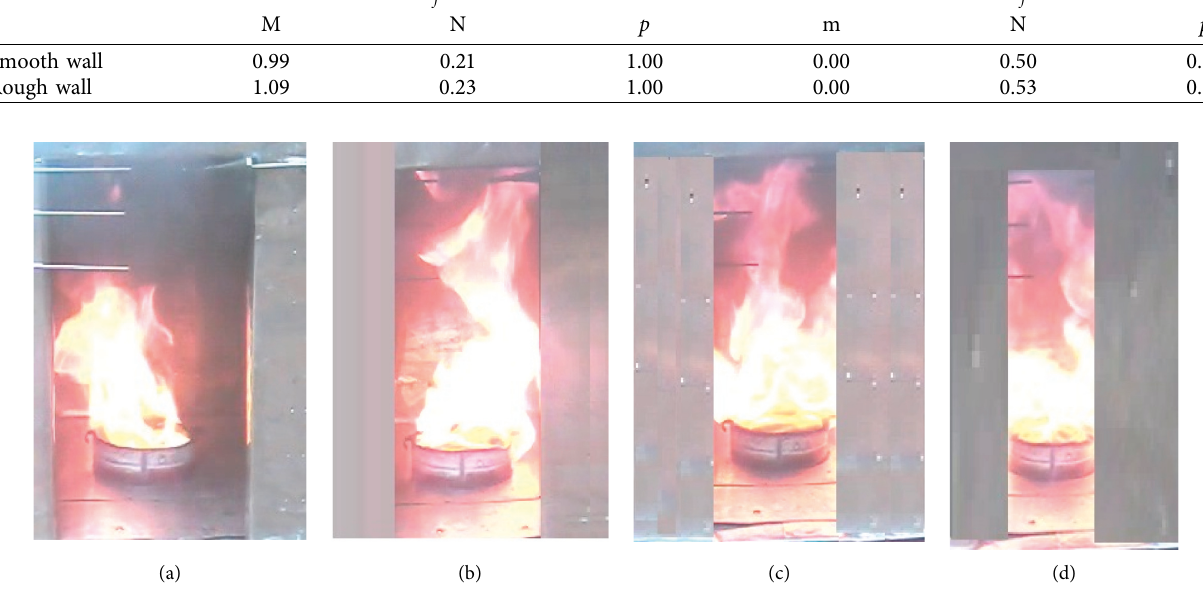
Figure 4: Image of the flame of each fire scene during the full development phase. (a) Scene 1. (b) Scene 2. (c) Scene 3. (d) Scene